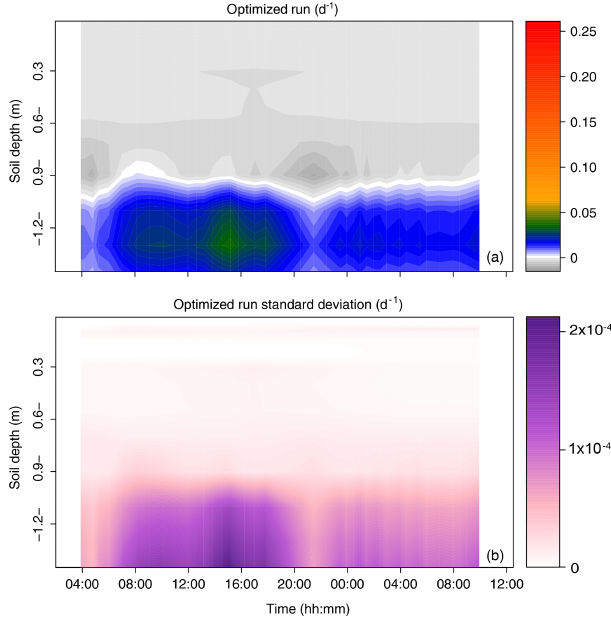
Figure 6. Time series of the profiles of root water uptake per unit soil volume (sink term, d − 1 ) computed with the physically based model. (a) Sum of sink terms across the 60 groups of the popula- tion. (b) Variability of the sink terms within the 60 groups of the population (1 standard